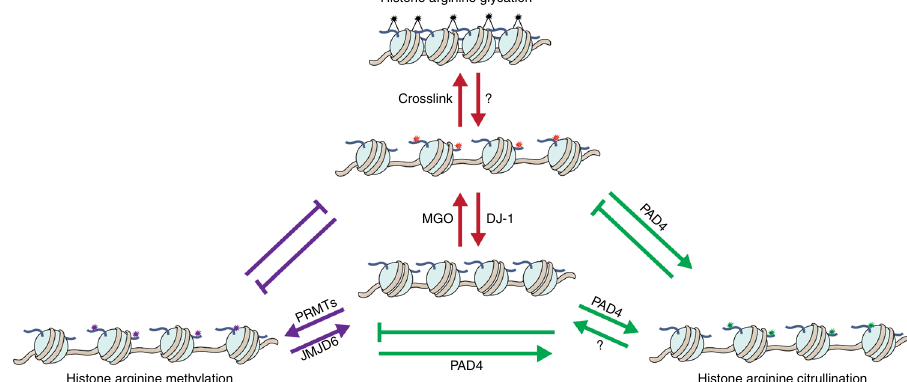
Fig. 4 Glycation, citrullination, and methylation have an interaction network. A proposed model showing the three-way crosstalk of histone glycation, citrullination, and